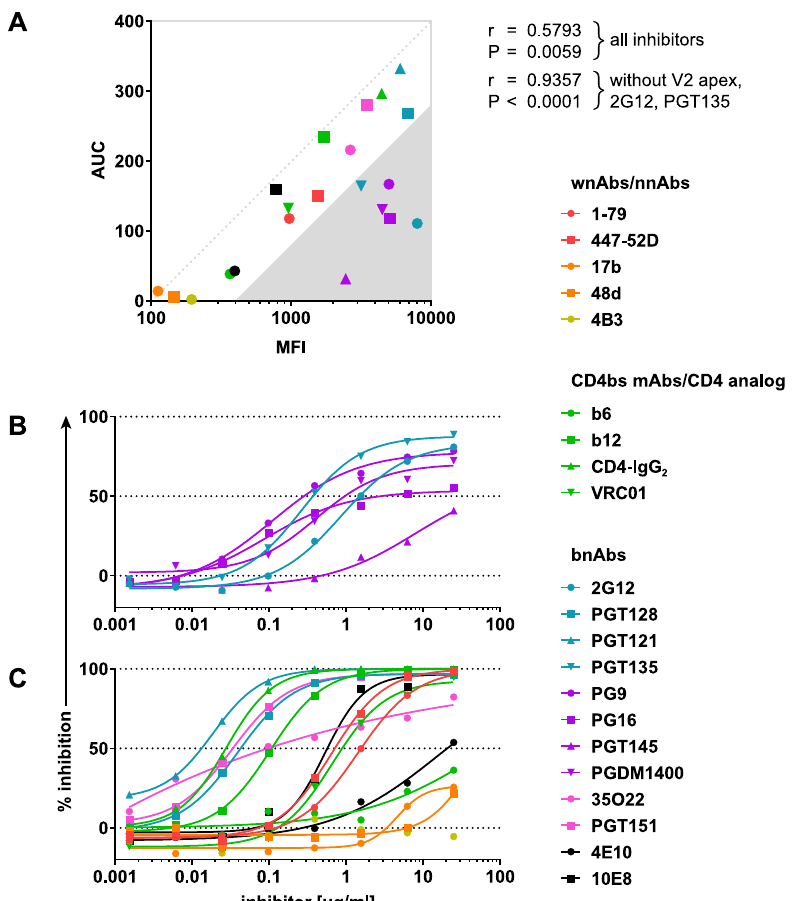
Fig 5. Relationship between BaL.01 neutralization and Env binding capacity. (A) Correlation between the inhibitor binding to the native, CD4-unbound BaL.01 Env (MFI data from Fig 4) and neutralization of the BaL.01 pseudovirus expressed as the AUC derived from neutralization data shown in panels B and C. Pearson’s r coefficients and respective P values were calculated taking into consideration either all probed inhibitors or all inhibitors excluding V2 apex bnAbs (PG9, PG16, PGT145, PGDM1400), 2G12, and PGT135. (B, C) Inhibition curves of BaL.01 pseudovirus neutralization assay for (B) V2 apex bnAbs, 2G12, and PGT135 and (C) other mAbs and inhibitors. Binding/ neutralization relationships for MN.3, JR-FL, and BG505_T332N Envs as well as the corresponding inhibition curves are depicted in S10 Fig. Data represent a single experiment. AUC, area under the inhibition curve; BG505_T332N, BG505.W6M.ENV.C2_T332N; bnAb, broadly neutralizing antibody; CD4bs, CD4 binding site; Env, envelope glycoprotein; mAb, monoclonal antibody; nnAb, nonneutralizing antibody; MFI, mean of fluorescence intensity; V2, second hypervariable; wnAb, weakly neutralizing antibody.